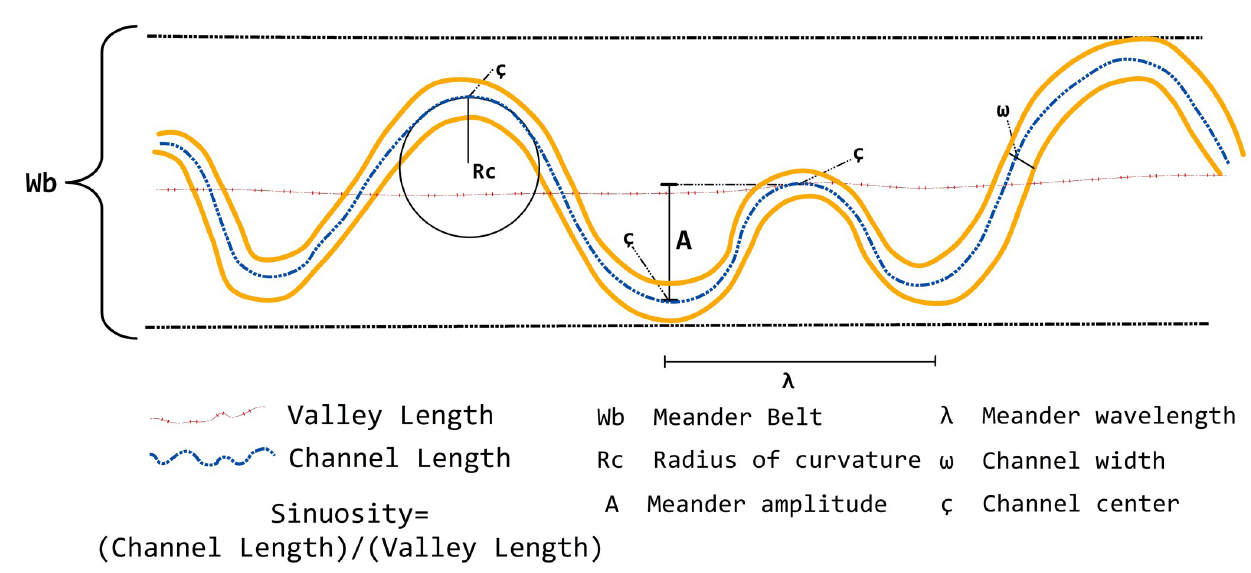
Fig 2. Schematic representation of meander geometry [30].